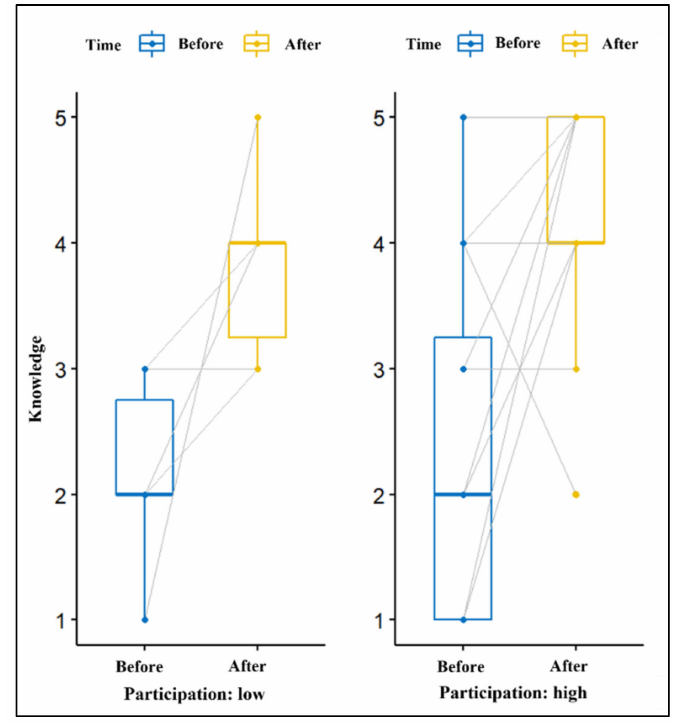
Figure 8. Paired t -tests for knowledge change by degree of